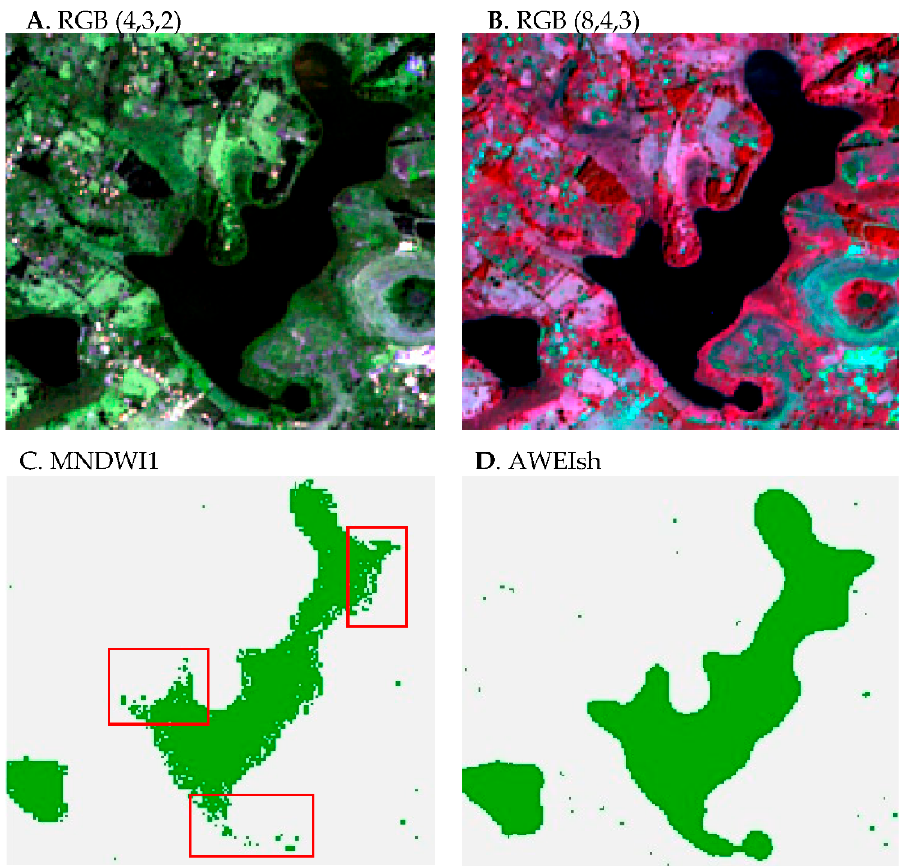
Figure 5. Comparing a case of lake extraction in site 1. Frame ( A ) is Sentinel-2 MSI RGB (4,3,2) 10 m natural-color image, Frame ( B ) is Sentinel-2 MSI RGB (8,4,3) false-color composite. Frame ( C ) shows MNDWI1 extraction of Lake Saka with omitted portions (red rectangles), while Frame ( D ) is a more efficient extraction of the same lake using AWEIsh.